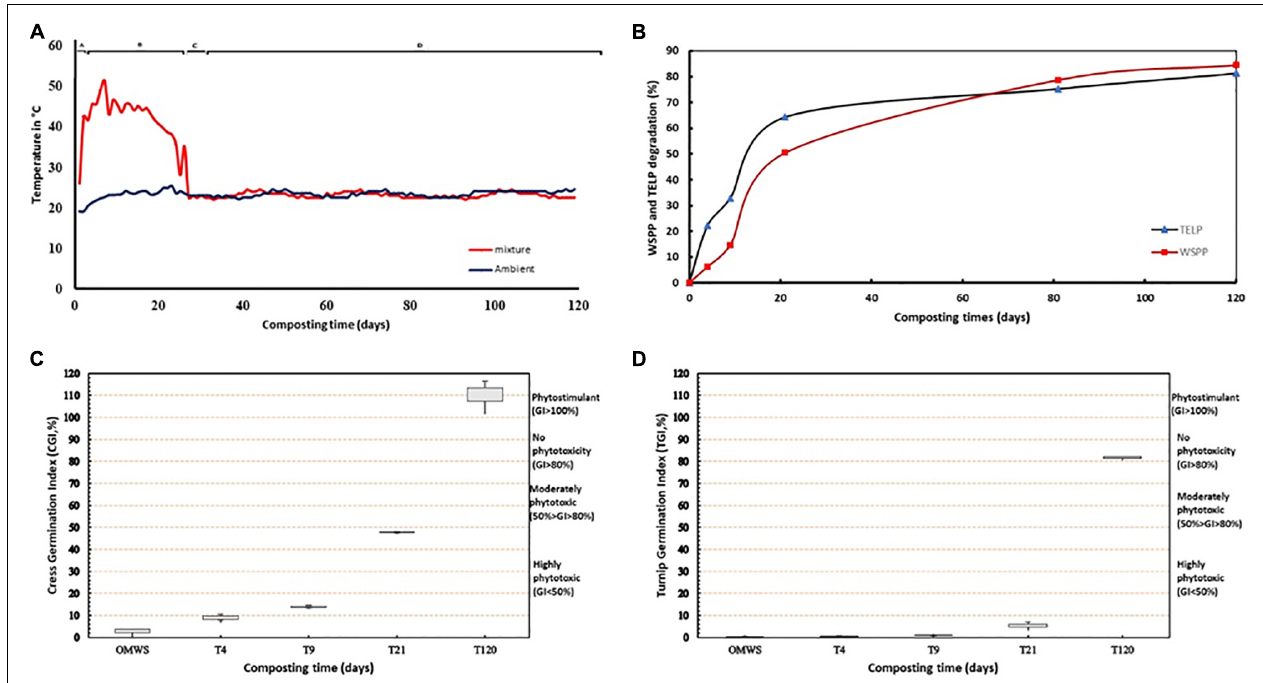
FIGURE 1 | (A) Temperature evolution during the composting process. (B) Percentage degradation of total extracted lipids (TELP) and Water-soluble polyphenols (WSPP) during composting. (C,D) Germination Index (GI%) of cress and turnip, respectively. Seeds were treated with extract of OMWS compost after 4 days (T4),